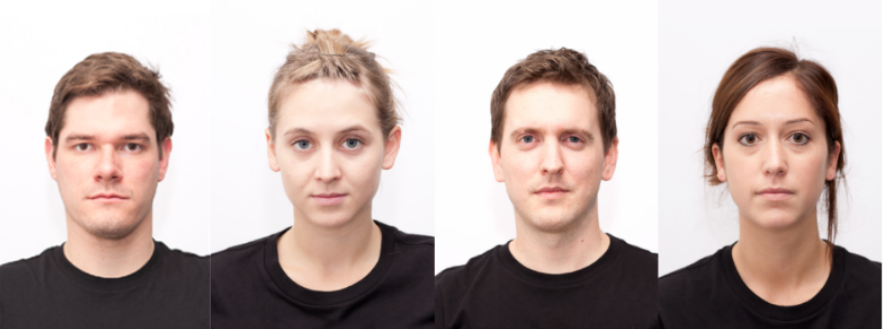
Figure 3. Example images taken from the BFD dataset [48].